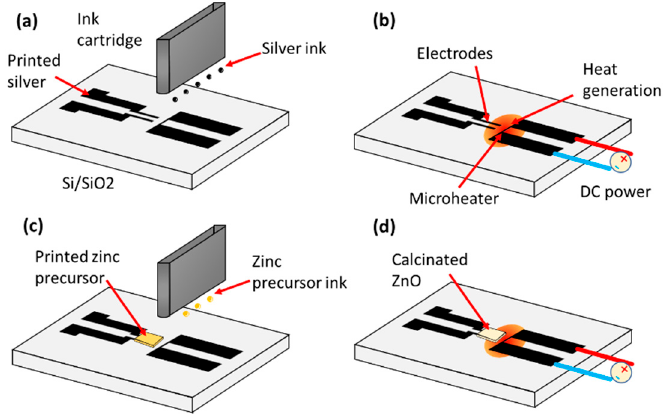
Figure 1. Fabrication step of the sensor using including printed micro-heater. ( a ) Printing of conductive pattern for the metal contacts and heater. ( b ) Applying direct current (DC) power to the micro-heater to generate heat and sinter silver. ( c ) Deposition of zinc salt ink over the printed electrodes. ( d ) Applying DC power again to the micro-heater to calcinate ZnO.